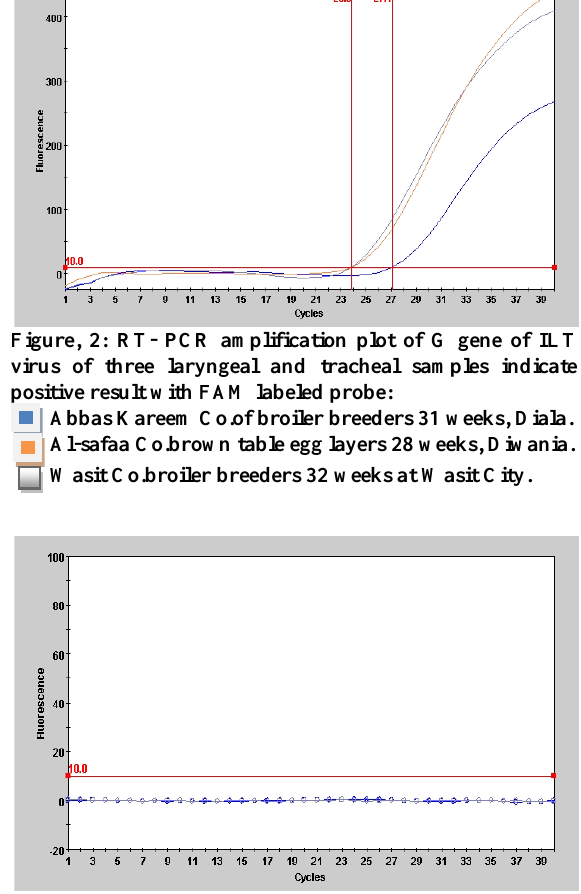
Figure, 3: RT- PCR amplification plot of glycoprotein J for detection of attenuated isolates that lack G gene of ILT virus of two laryngeal and tracheal samples indicate negative result with Quasar labeled probe: ILTV RT-PCR wild type for larynx and trachea of brown table egg layers (28 weeks old) from Jezera farm At Al- Siwara.